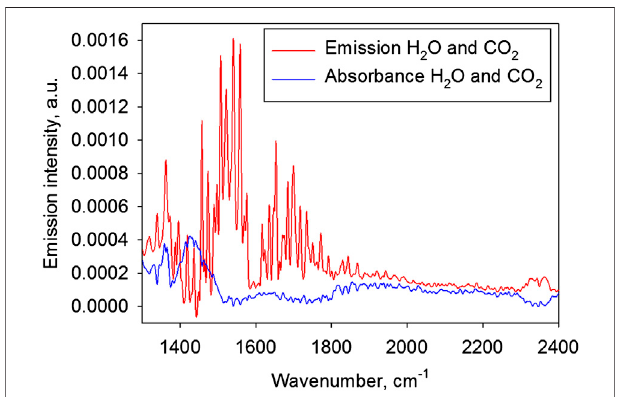
FIGURE 2 | The air spectra (without sample) measured against the cold background. Red line: the emission spectrum (the spectrometer pumped down to a vacuum of 0.9 mbar); blue line: the absorption spectrum (atmospheric air pressure in the spectrometer).